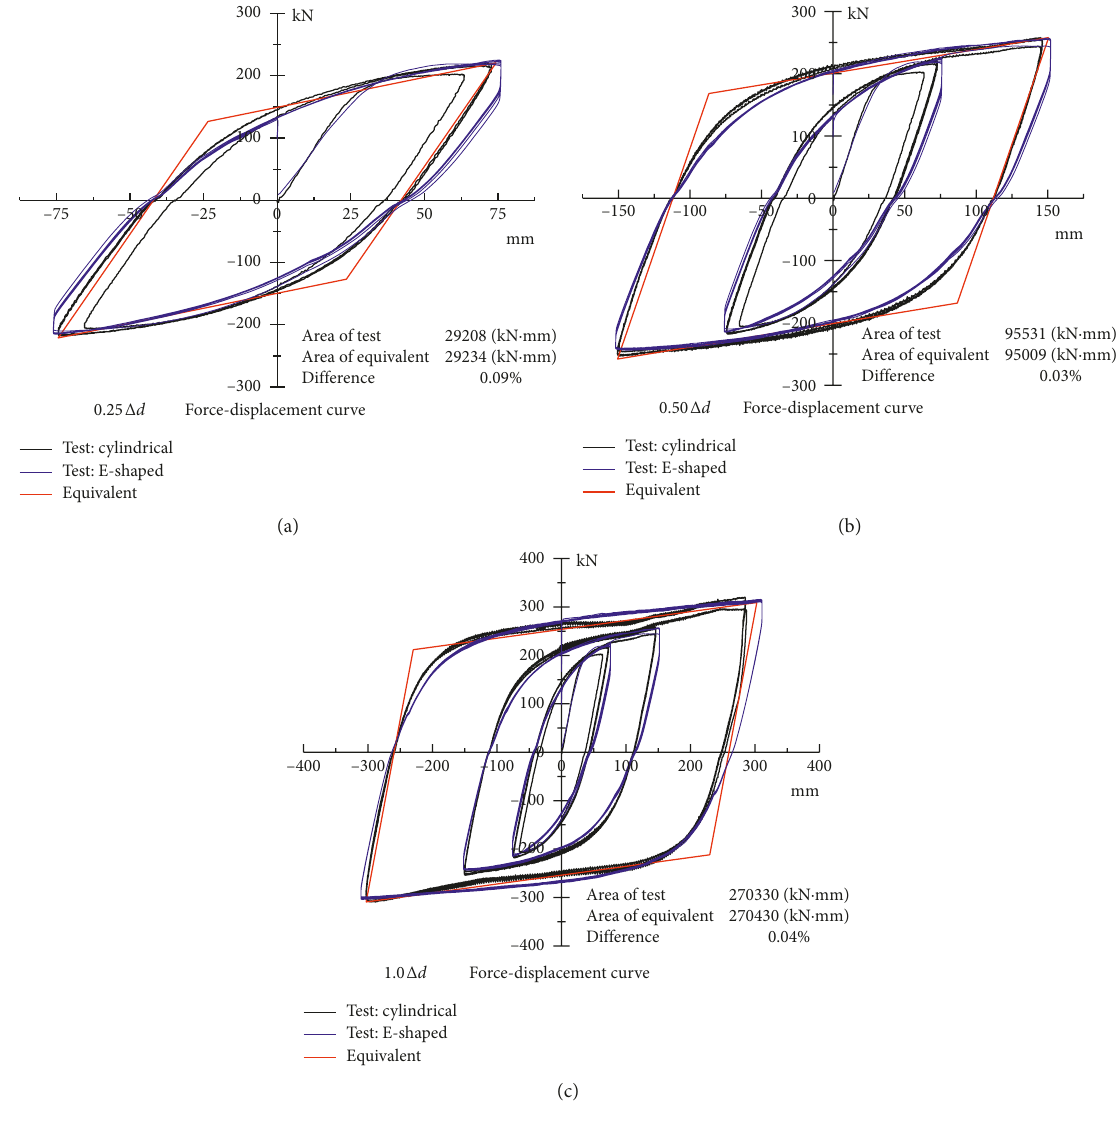
Figure 18: Test results. (a) 0.25. (b) 0. 5. (c) 1.0 Δ d . Table 3: Deviation of mean value of third cycle yield